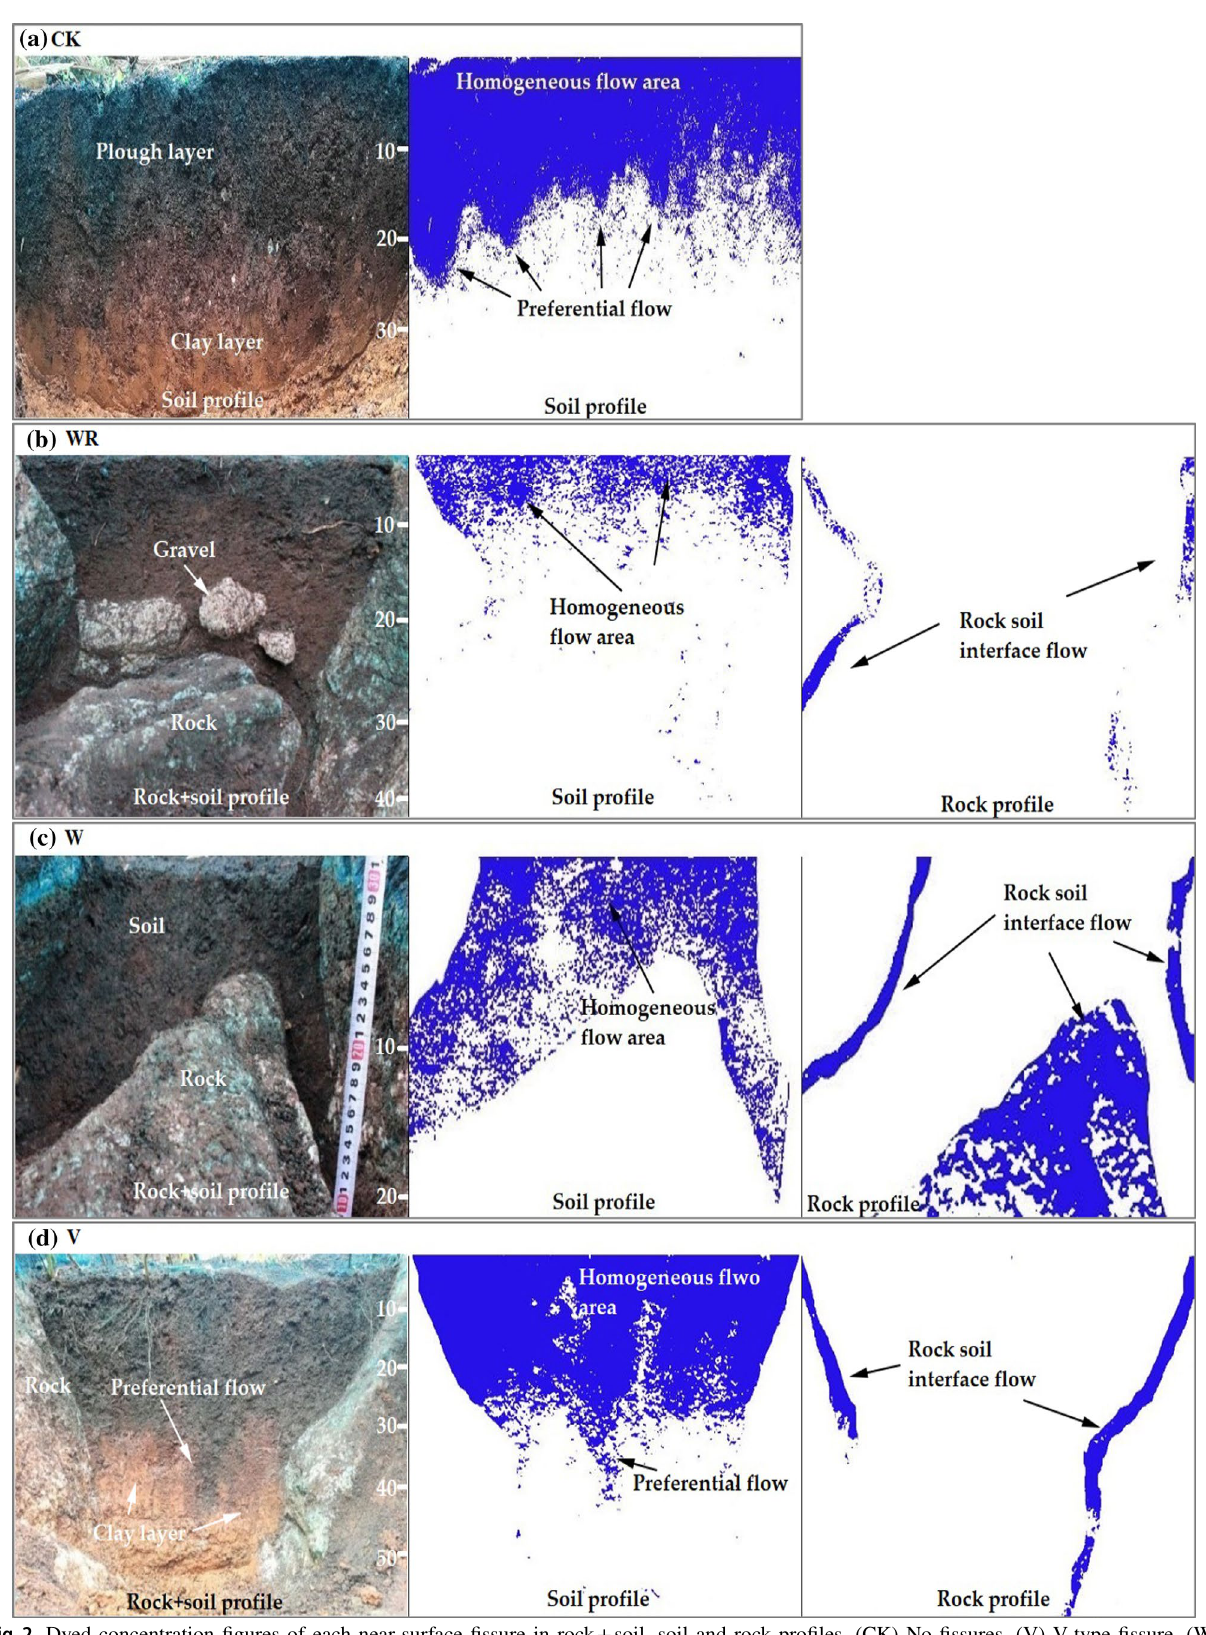
Fig. 2 Dyed concentration figures of each near-surface fissure in rock + soil, soil and rock profiles. (CK) No fissures, (V) V-type fissure, (W) W-type fissure, (WR) W + rocks-type fissure, (IV) inclined V-type fissure, (F) conduit